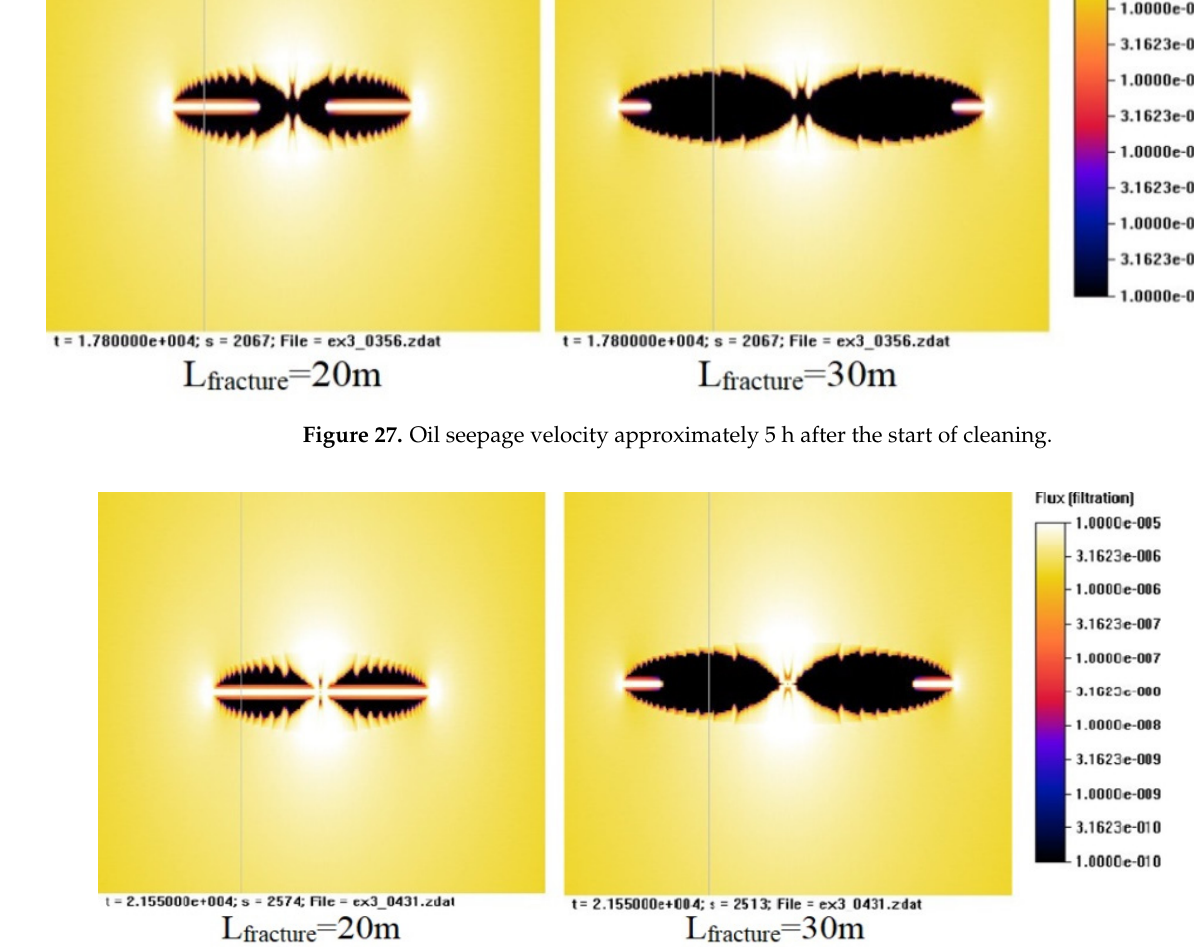
Figure 28. Oil seepage velocity approximately 6 h after the start of cleaning.